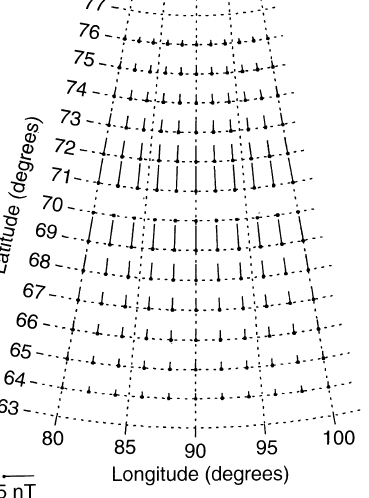
Fig. 1. Magnetic field of an eastward-flowing ionospheric sheet current of 1000 mA/m at 70 (cid:14) latitude, immediately below the ionosphere; the 637-nT magnetic field vectors at the latitude of current flow have been deleted to show the small ‘‘nonlocal’’ e(cid:128)ect between current and horizontal magnetic field on